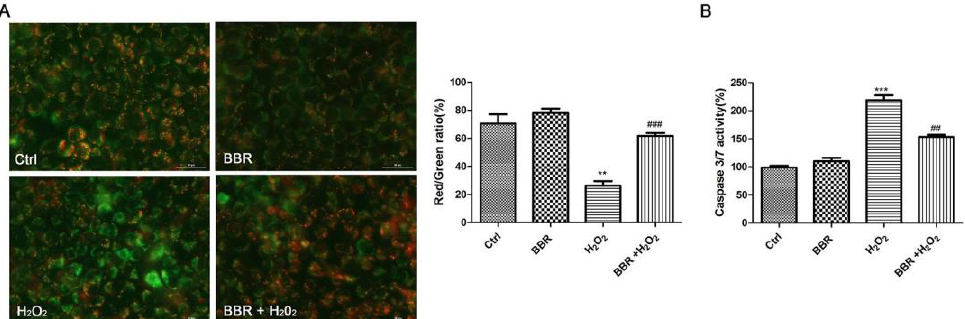
Figure 3. BBR attenuated H 2 O 2 -induced loss of mitochondrial membrane potential (Δψm) and activation of caspase 3/7 in D407 cells. After pre-treatment with 3 μM BBR or 0.1% DMSO (vehicle control) for 2 h, D407 cells were incubated with or without 100 μM H 2 O 2 for another 24 h. ( A ) Δψm was determined by JC-1 assay; ( B ) Quantification of caspase 3/7 activity was determined by caspase 3/7 activity assay. ** indicate p < 0.01, *** indicate p < 0.001 versus the control group; ## indicate p < 0.01, ### indicate p < 0.001 versus the H 2 O 2 -treated group were considered significantly different.